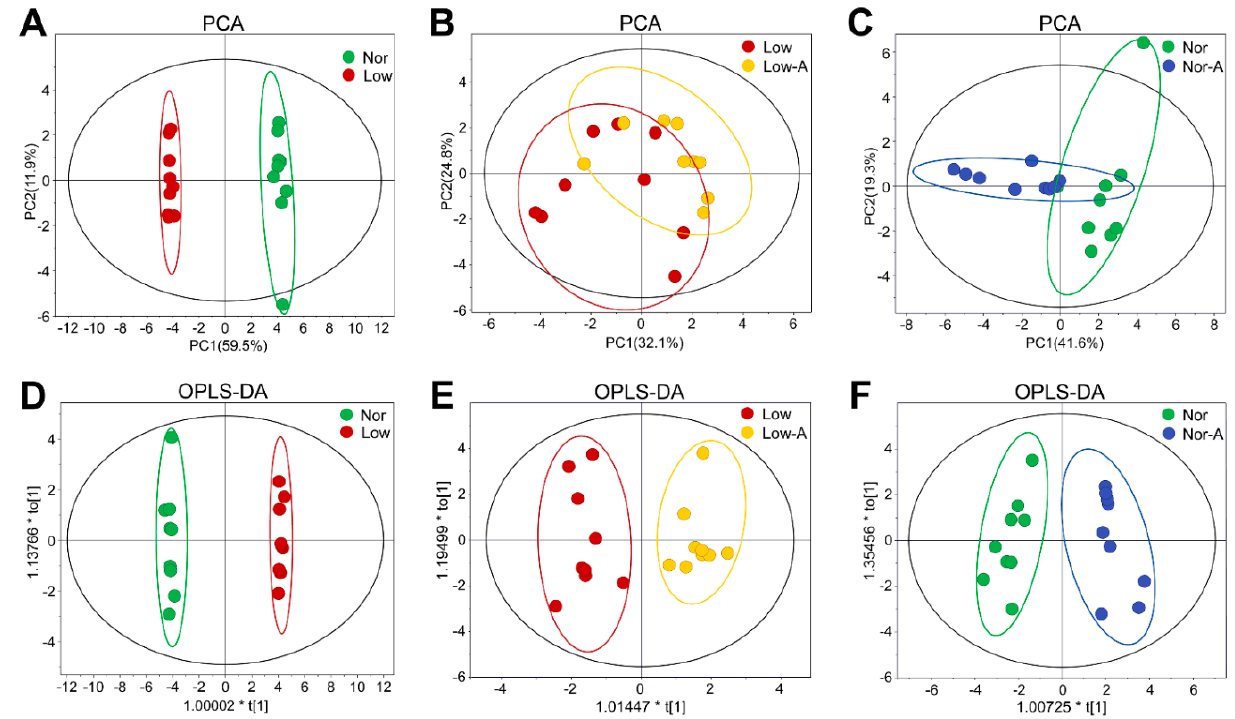
Figure 3. Multivariate analyses for 1 H NMR spectra recorded on aqueous extracts derived from C2C12 myoblasts of the Nor, Nor-A, Low, and Low-A groups. ( A – C ) PCA scores plots of the Low and Nor groups, the Low-A and Low groups, the Nor-A and Nor groups; ( D – F ) OPLS-DA scores plots of the Low and Nor groups (R2: 0.999; Q2: 0.996), the Low-A and Low groups (R2: 0.918; Q2: 0.761), the Nor-A and Nor groups (R2: 0.927; Q2: 0.838). The ellipses indicate the 95% confidence limits.